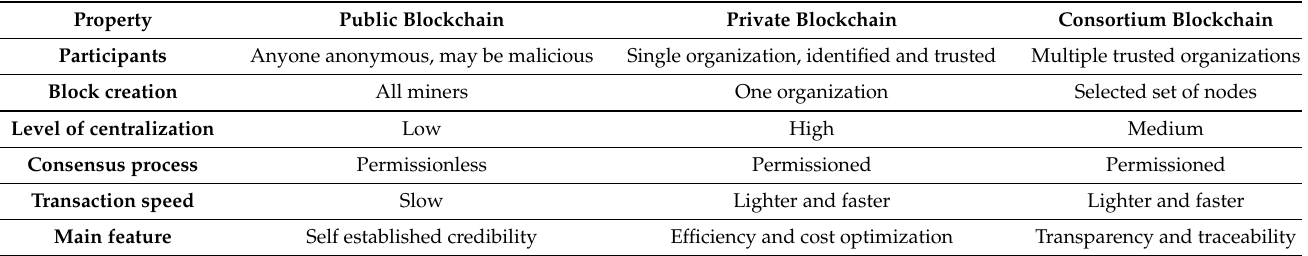
Table 2. Comparison of different types of